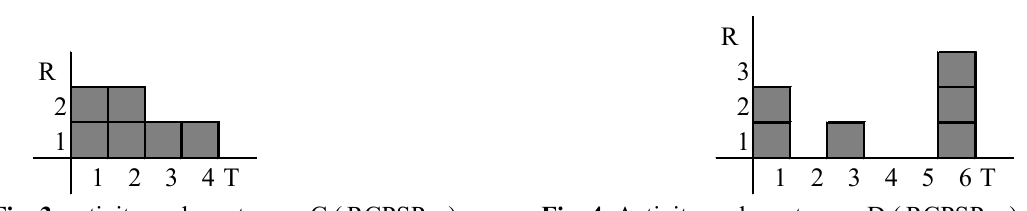
RCPSP ). Fig. 4. Activity under category D ( (C)